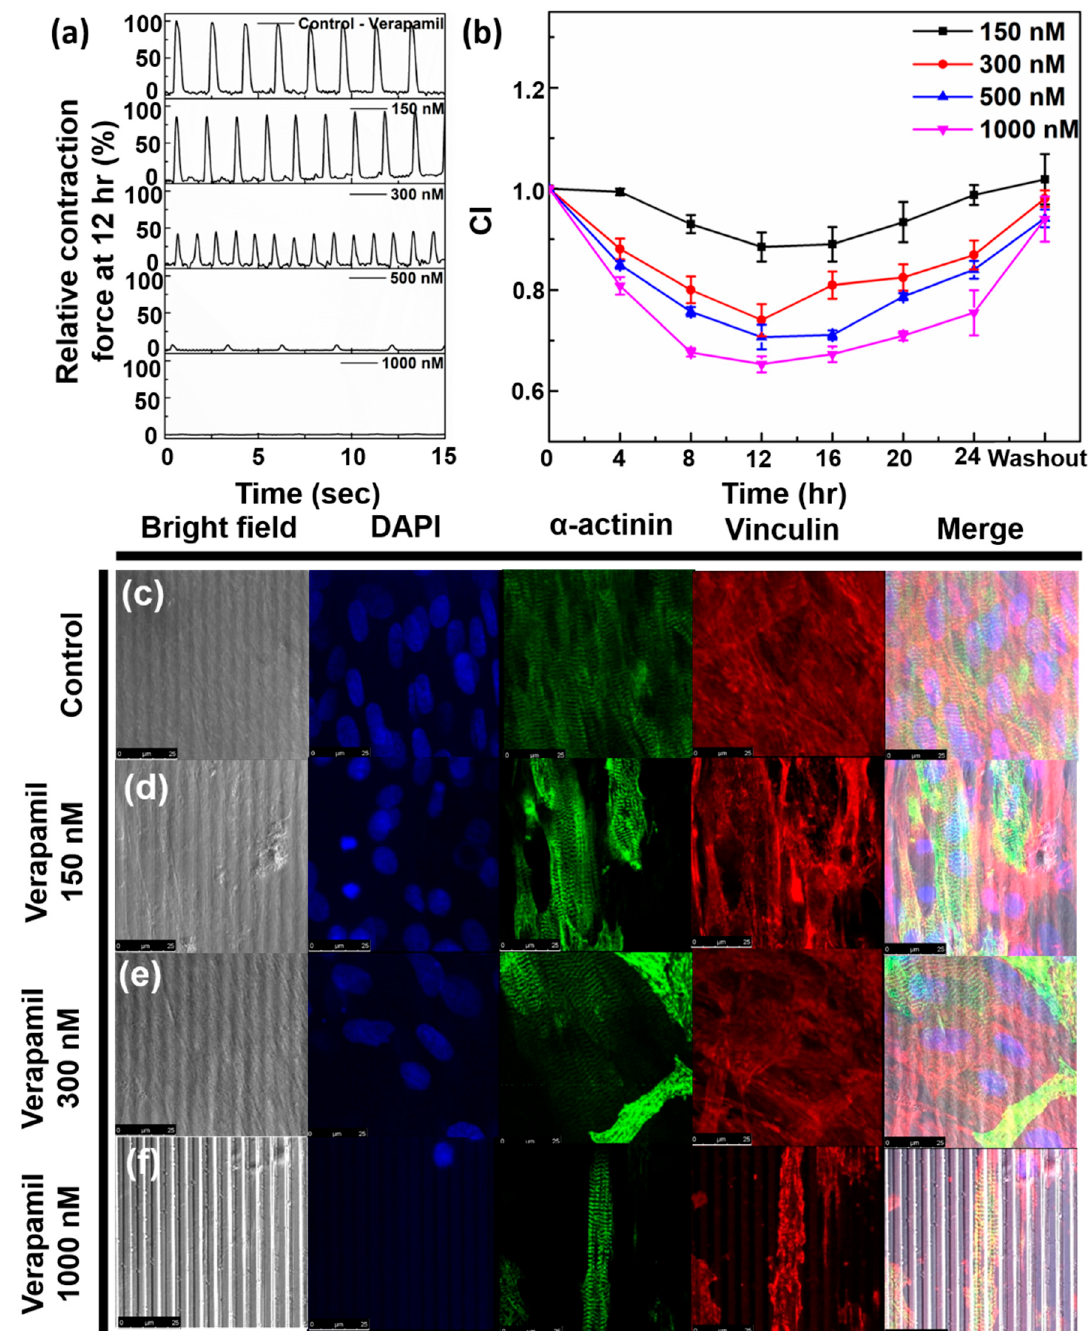
Figure 6. ( a ) Normalized contraction force on addition of Verapamil of concentrations 150 nmol/L, 300 nmol/L, 500 nmol/L, 1000 nmol/L after 12 h, ( b ) Normalized impedance output on addition of Verapamil of concentrations 150 nmol/L, 300 nmol/L, 500 nmol/L, 1000 nmol/L up to 24 h, ( c–f ) Immunocytochemistry (ICC) staining data for ( c ) control, ( d ) 150 nmol/L, ( e ) 300 nmol/L, ( f ) 1000 nmol/L Verapamil. Scale bar = 25 µm.